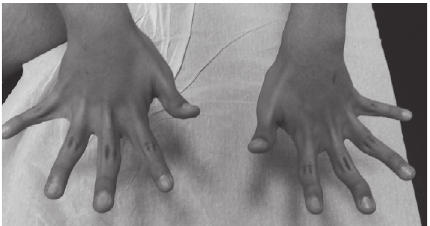
Figure 1: Clinical view of the 12-year-old patient showing marked hypotrophy of the intrinsic muscles groups of his hands and fingers.